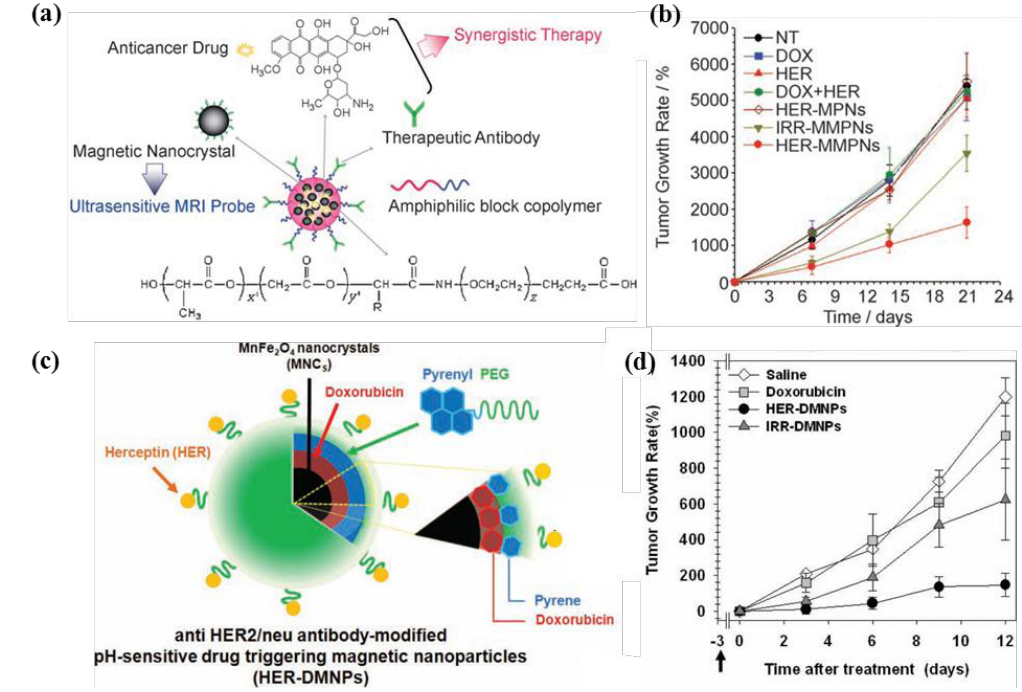
Figure 6. Schematic illustration of ( a ) multifunctional magneto-polymeric nanohybrids (MMPNs) and ( c ) Herceptin-modified pH-sensitive drug-delivering magnetic nanoparticles (HER-DMNPs) for cancer therapy, respectively. Comparative therapeutic efficacy study